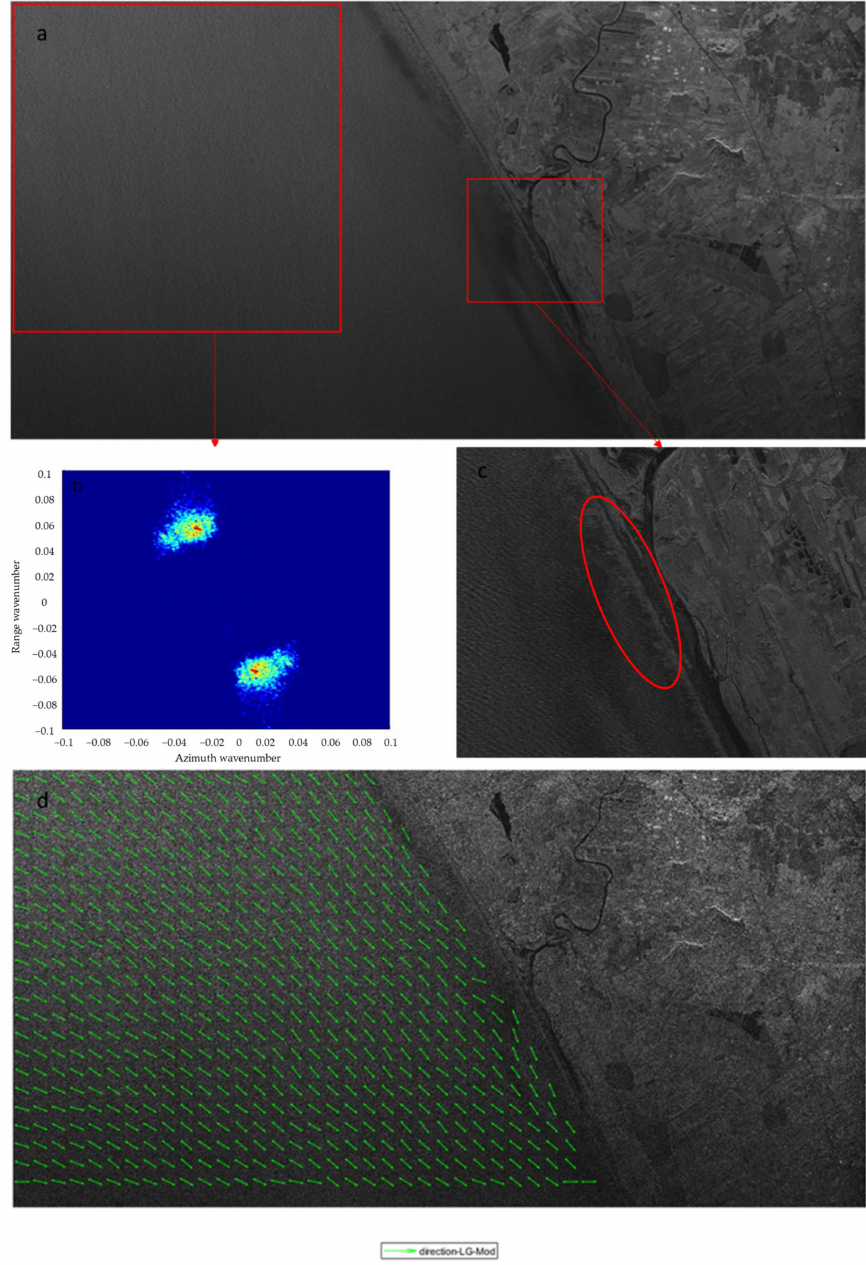
Figure 2. SAR image of North America obtained by striping mode and some preliminary analysis results. ( a ) Original SAR image whose gridding size is 14,000 × 7167 (horizontal × vertical) and spatial resolution is 3 m. ( b ) SAR image spectra in the area enclosed by left red rectangle in Figure 2a. ( c ) Rip current in the right red rectangle in Figure 2a, which is shown in the red oval border. ( d ) Wind direction with 180 ◦ blur retrieved by